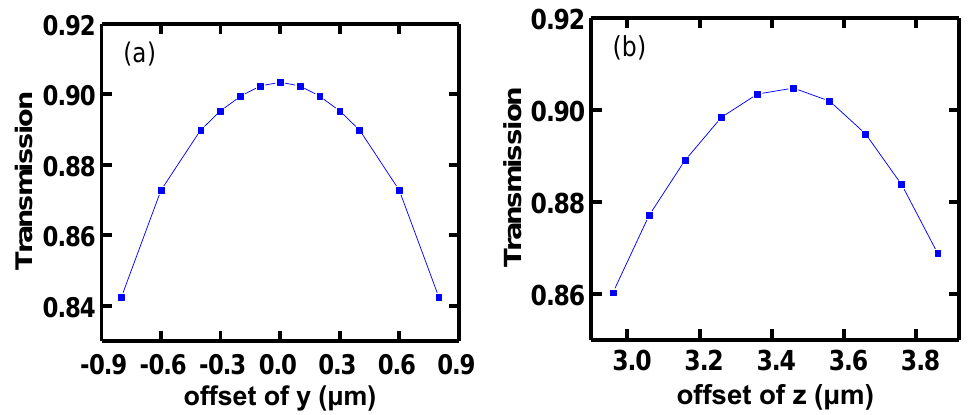
Figure 7. Alignment tolerances of silicon SSC in the y axis (the direction of the waveguide width) ( a ) and the z axis (the direction of material growth) ( b ). The alignment tolerance of the upper Si 3 N 4 waveguide in the y axis is also performed